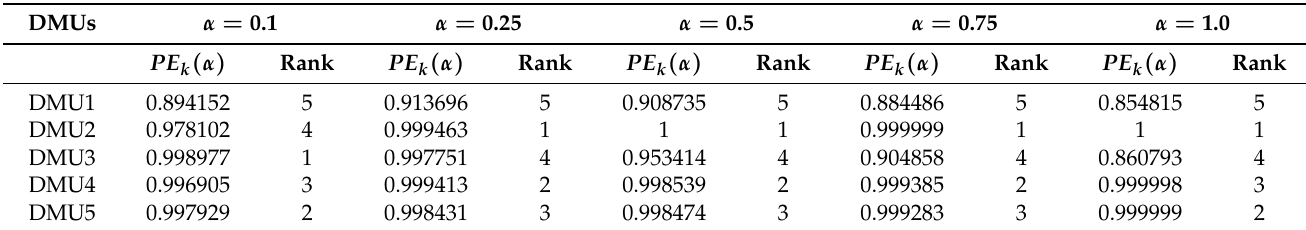
Table 2. Efficiency scores of DMUs and